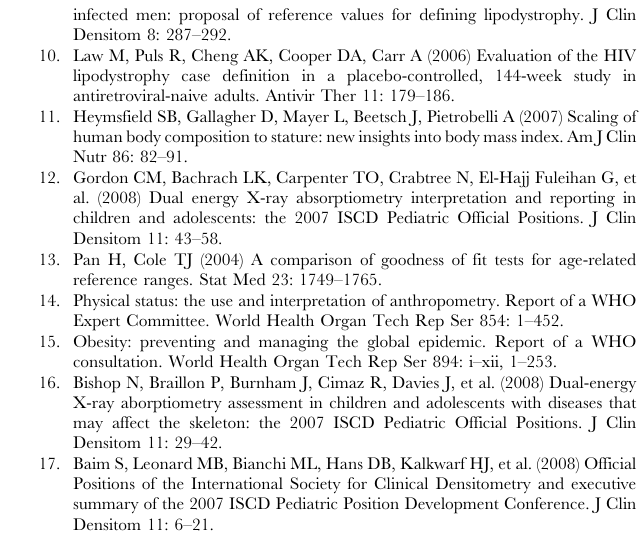
Table S4 Trunk to Limb Fat Mass Ratio vs. Age in Adult subjects. Table S5 Lean Mass/Height 2 (kg/m 2 ) vs. Age in adult subjects. DOC) Table S6 Appendicular Lean Mass/Height 2 (kg/m 2 ) vs. Age in adult subjects. Table S7 Total Body BMD (g/cm 2 ) vs. Age in adult subjects. DOC) Table S8 Total Body BMC (g) vs. Age in adult subjects. DOC) Table S9 %Fat (%) vs. Age in pediatric subjects. DOC) Table S10 Lean Mass/Height 2 (kg/m 2 ) vs. Age in pediatric subjects. Table S11 Total Body BMD (g/cm 2 ) vs. Age in pediatric subjects.